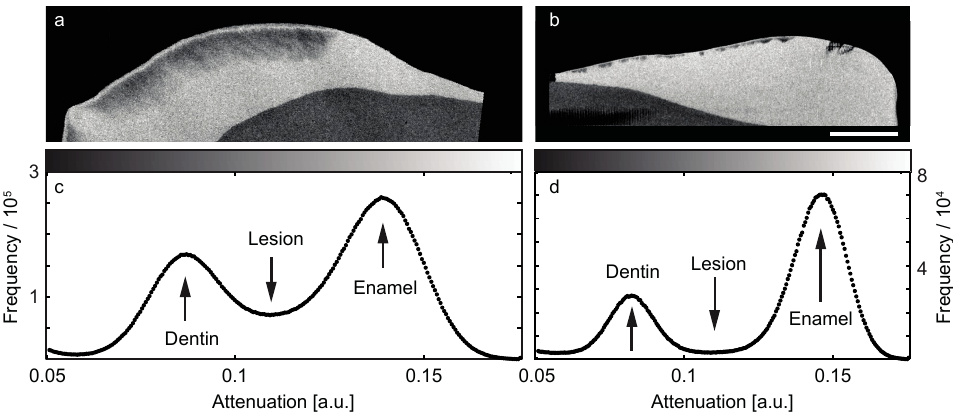
Figure 2. Selected slices through the µCT datasets of tooth slices with natural ( a ) and artificial ( b ) lesions. Affected regions exhibit X-ray attenuation reduced with respect to the healthy enamel. The related histograms of the three-dimensional data are shown in the diagrams ( c , d ). The length of the bar corresponds to 1 mm.